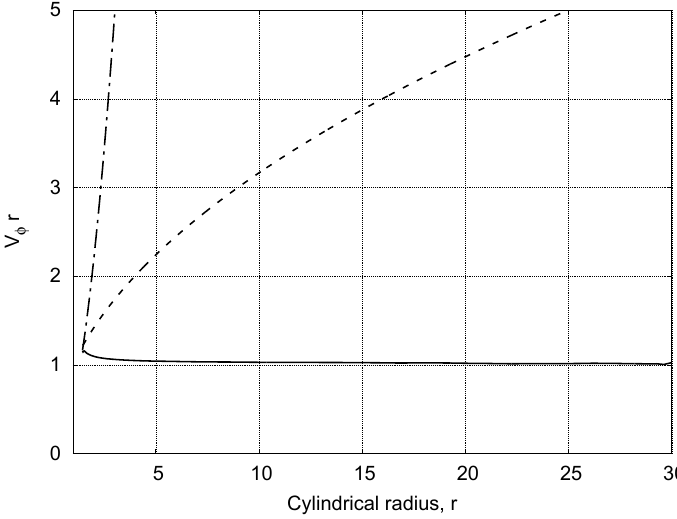
Figure 3. Distribution of the angular momentum of the flow at the equatorial plane (solid line). Dashed line—angular momentum at the Keplerian rotation, and dashed-dotted line—angular mo- mentum at the rigid rotation. The equatorial flow at ω = 0.999 remains